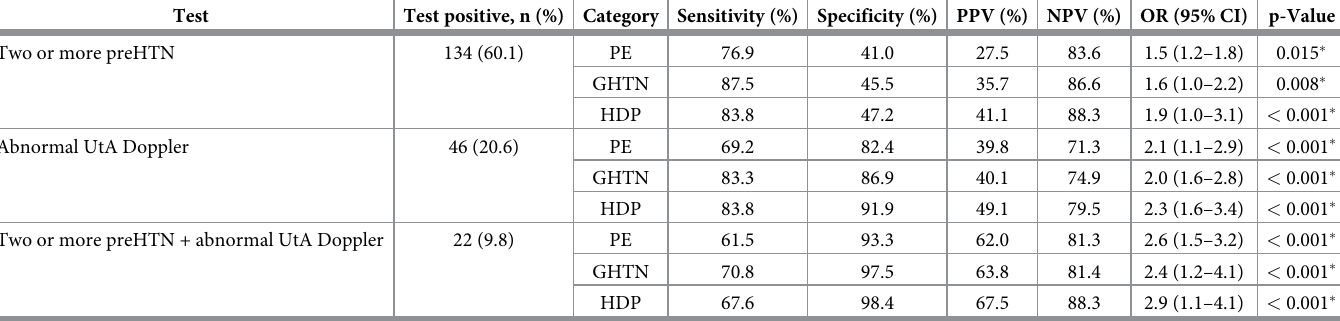
Table 3. Predictive capability of twice or more preHTN measured, abnormal findings of uterine artery Doppler velocimetry, and the combination of both parame- ters in the preHTN group.